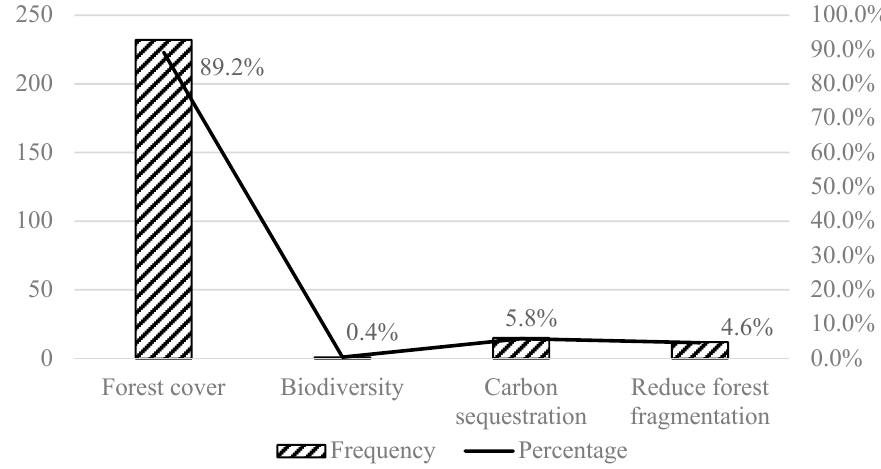
Figure 2. Evaluation indicator distribution of the ecological e ff ects of protected areas by number and by percentage.